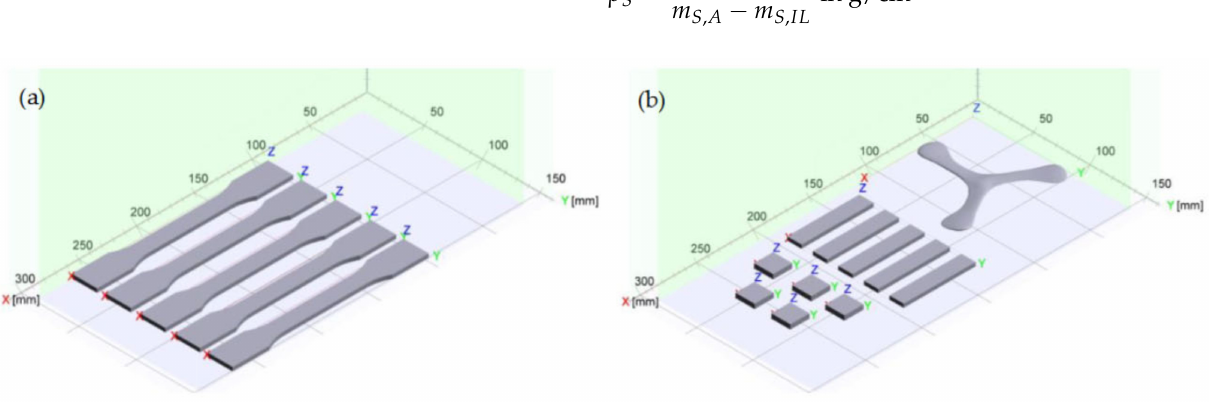
Figure 2. Layout of the build jobs: ( a ) five tensile bars, ( b ) five density cubes, five microscopy cuboids and one three-bladed propeller for demonstration of producibility of complex